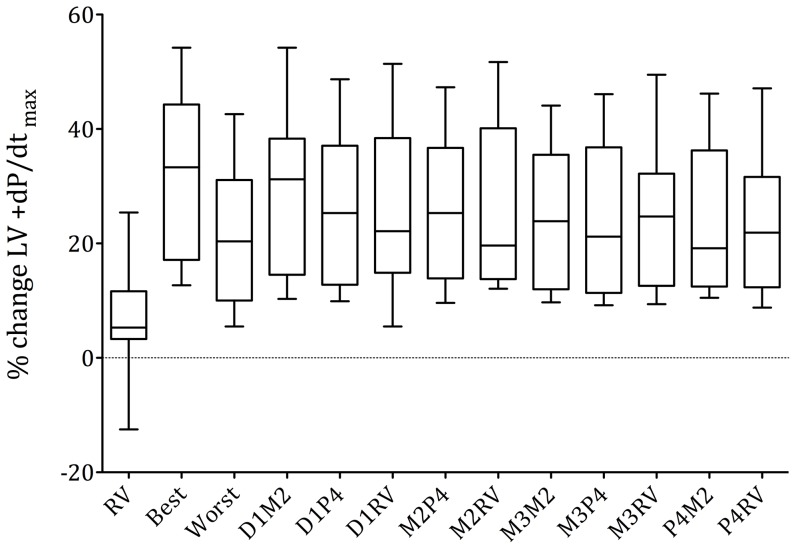
Averaged results over all patients - Box plots of %ΔLV +dP/dtmax, of all LVPCs, averaged over all 16 patients (5–95% percentile).RV stimulation consistently produced the least increase in LV +dP/dtmax. No differences were found between LVPCs with the same cathode.